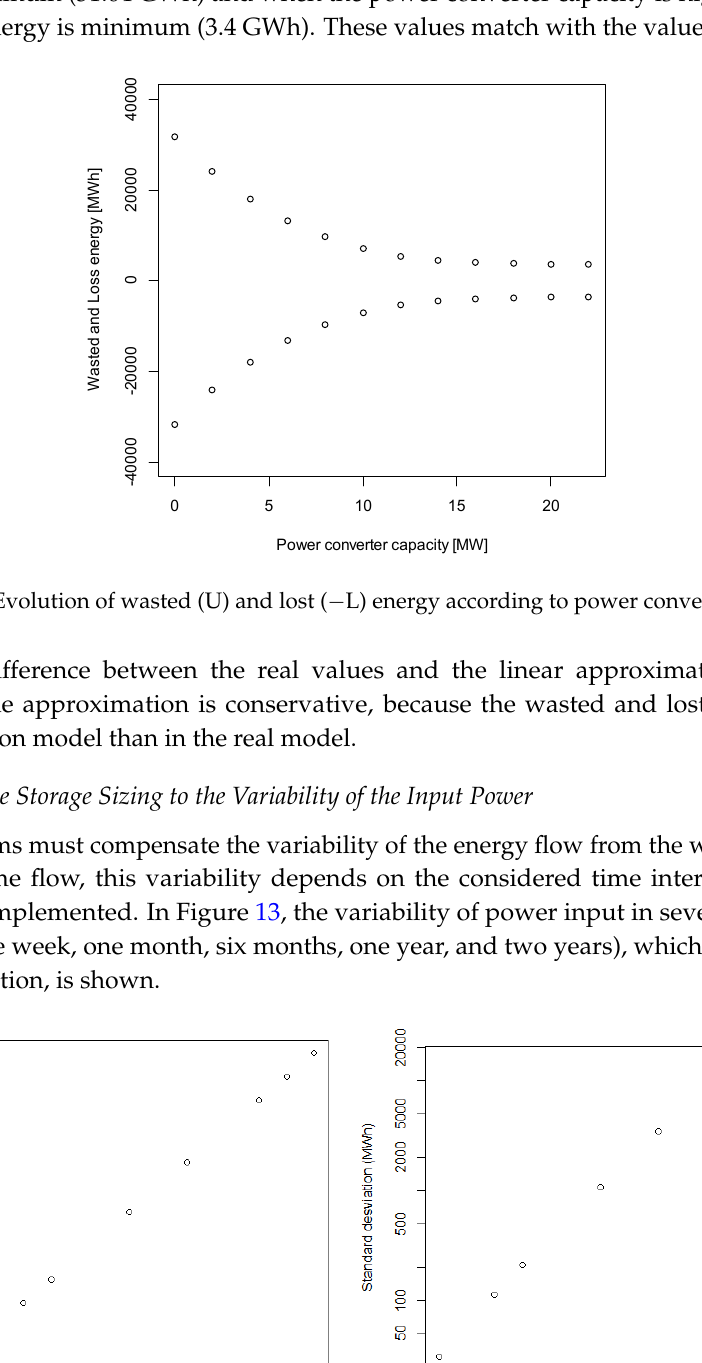
Figure 11. Evolution of waste (U) and loss energy ( − L) according to storage capacity.